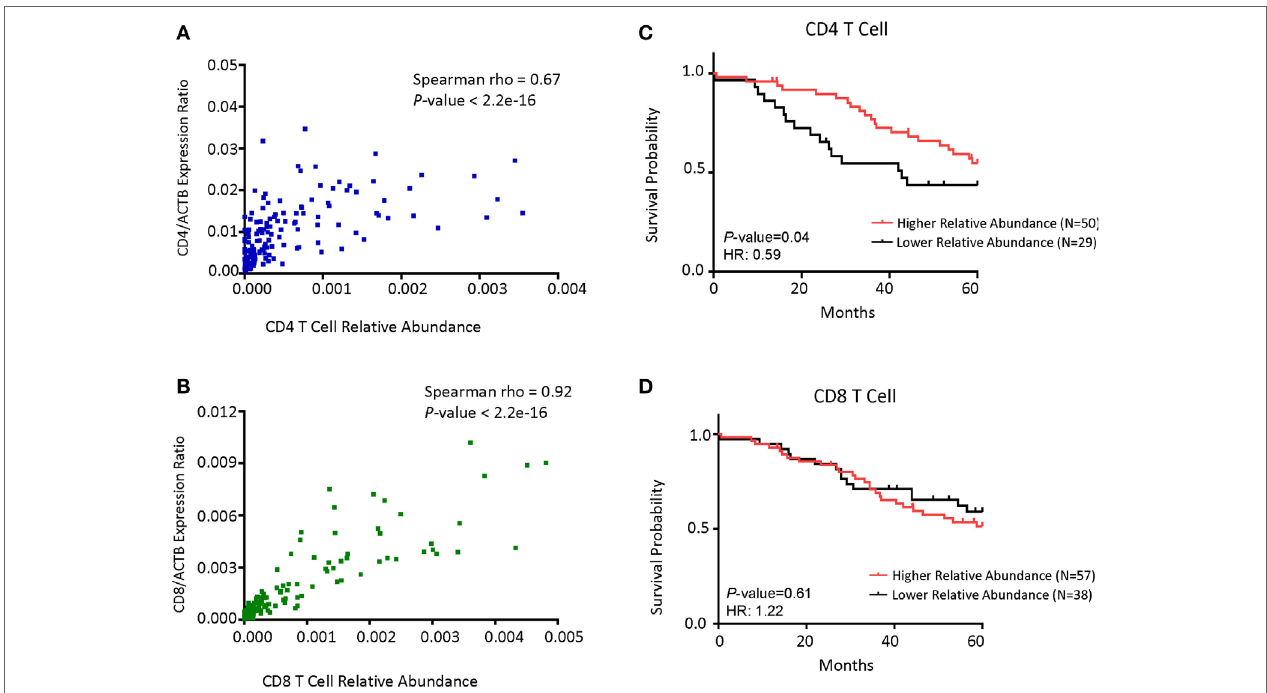
FigUre 4 | CD4 cell abundance is the principal determinant for prognosis in patients with MYCN non-amplified tumors. (a) Dot plot showing the correlations between CD4 gene expression normalized with the ratio of actin expression and CD4 T cell relative abundance. (b) Dot plot showing the correlations between CD8B gene expression normalized with the ratio of actin expression and CD8 T cell relative abundance. (c) Kaplan–Meier curves showing 5-year survival of neuroblastoma (NB) patients with MYCN non-amplified tumors according to their CD4 T cell relative abundance. (D) Kaplan–Meier curves showing 5-year survival of NB patients with MYCN non-amplified status according to their CD8 T cell relative abundance. NB samples were divided into Relative Abundance hi and Relative Abundance lo groups, respectively, based on the immune cell relative abundance data as detailed in Section “Materials and Methods.”. Correlation coefficient and P -value in (a,b) were determined using Spearman method. The hazard ratio and P -value displayed on the graphs are from the log-rank test and Gehan–Breslow– Wilcoxon